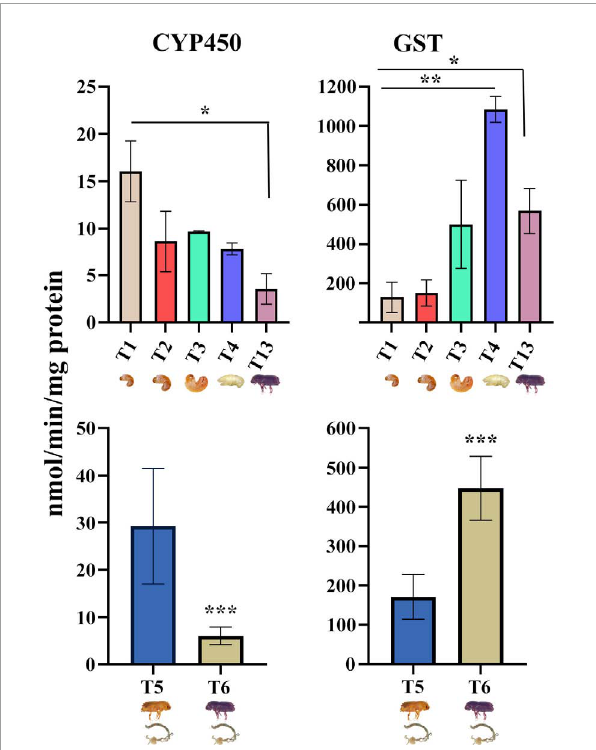
FIGURE14 The activities of selected enzymes, glutathione S-transferase (GST) and cytochrome P450 (CYP450), measured in the developmental and tissue-specific stages. The bars represent mean values and whiskers standard deviations in four biological replicates. One-way ANOVA was performed between the life stages (T1, T2, T3, T4, and T13) and Student’s t -test between guts of callow and sclerotized males (T6 vs. T5). * indicates that values are significantly different from each other at * p < 0.05, ** p < 0.01, *** p < 0.001. GST, and CYP450 activity are expressed as nmol/min/mg